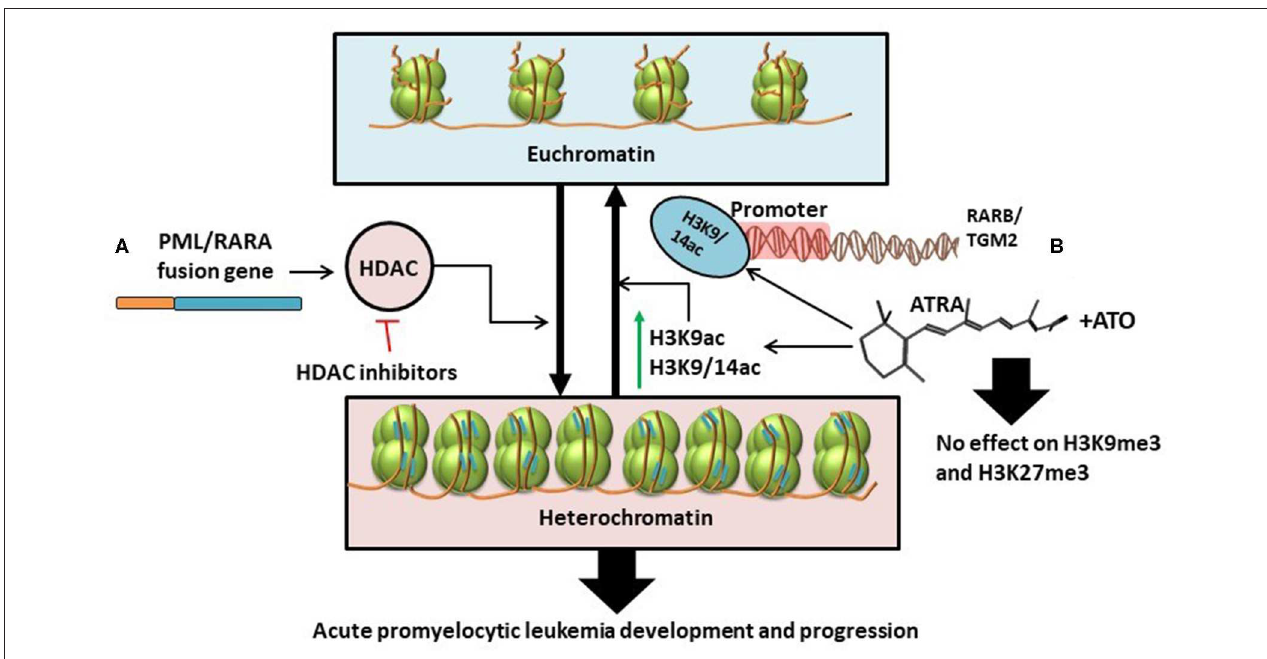
FIGURE 3 | (A) PML/RARA fusion gene stimulates the activity of histone deacetylases thus causing the transformation of euchromatin (transcriptionally active) into heterochromatin (transcriptionally inactive). This results in the development and progression of APL. The effects of this chain of events could be disrupted with the help of HDAC inhibitors ( 61, 62). (B) ATRA as single treatment or in combination with ATO specifically increases the levels of H3K9ac and H3K9/14ac leading to chromatin acetylation. H3K9/14ac enrichment following treatment is particularly targeted at the promoter regions of RARB and TGM2. Combination treatment with ATRA and ATO has little to no effect on histone methylation (H3K9me3 and H3K27me3) (